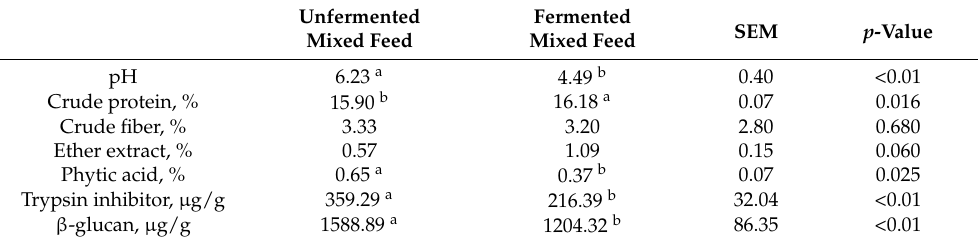
Table 3. Chemical composition of unfermented mixture and fermented mixture.